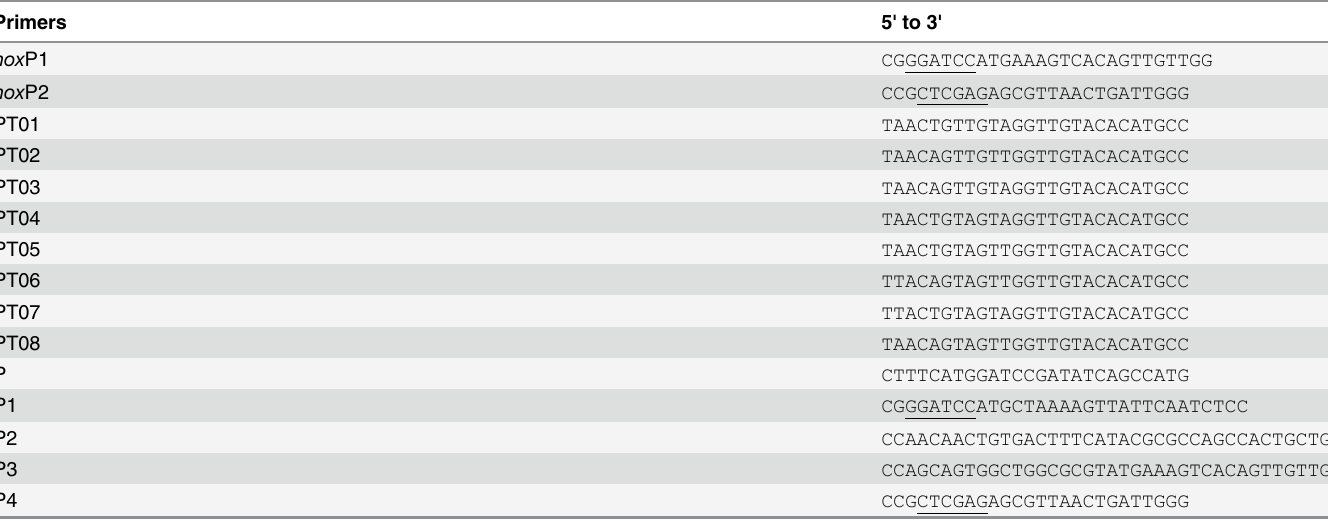
Table 1. Oligonucleotide primers used in this